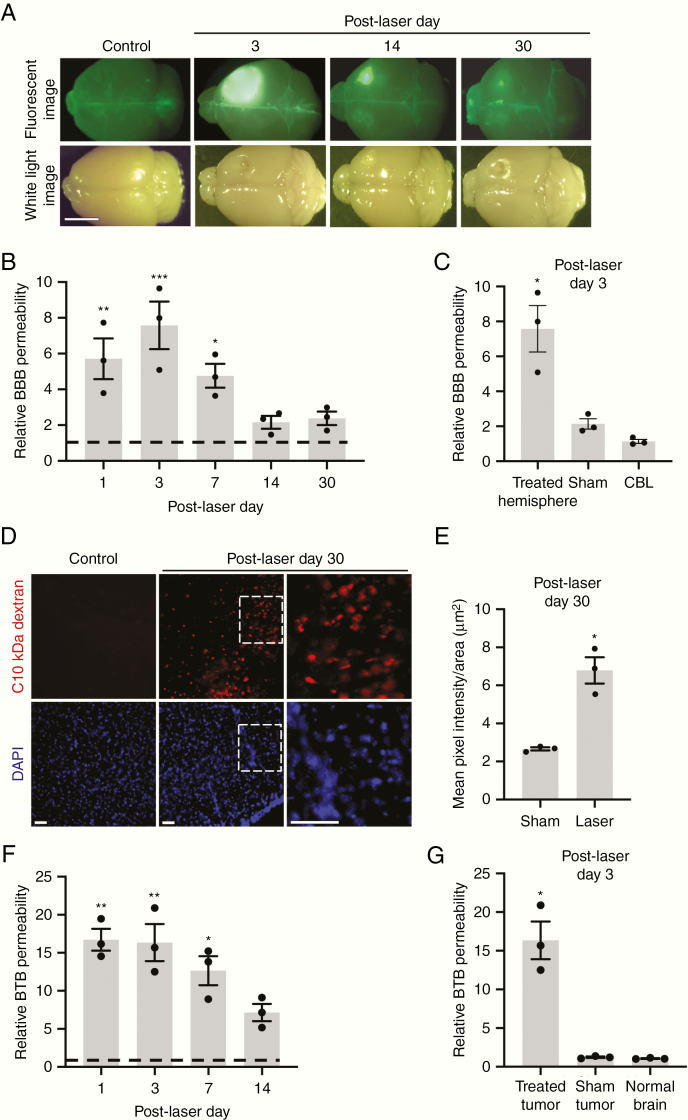
LITT increases BBB and BTB permeability in vivo. (A) Representative white light and fluorescence images of mouse brains harvested on the indicated days after intravenous fluorescein injection (n = 3 for each condition). LITT was performed in the right somatosensory cortex. Control = unmanipulated brain. Scale bar = 5 mm. (B) Animals treated as in A were assessed for tissue fluorescein uptake (normalized to control brains) on indicated post-LITT days. Control = 1 (dotted line). Data represent mean ± SEM. Laser increased BBB permeability compared to control (n = 3 for each condition, ANOVA, *P < .05, **P < .01, ***P < .001). (C) Relative BBB permeability was measured as in B on post-laser day 3 in indicated brain regions. LITT increased BBB permeability in the treated forebrain hemisphere, but not in the cerebellum (CBL) of the same brain or sham treatment (insertion of optical fiber) (n = 3 for each condition, ANOVA, *P < .01). (D) Animals treated with laser were injected intravenously with 10 kDa dextran on post-LITT day 30, and brains processed for immunofluorescence on free-floating 50 µm sections to assess dextran penetration. Representative images are shown (n = 3 for each condition). Scale bar = 50 µm. (E) Brain permeability of 10 kDa dextran was quantified by the mean pixel intensity of fluorescence divided by area (µm2). Data represent mean ± SEM (n = 3 for each condition, unpaired t-test, *P < .01). (F) Animals were orthotopically implanted with GL261 tumor cells, and laser treatment to the tumor performed 7 days later. Relative BTB permeability (normalized to control brain) was assessed by quantification of tissue fluorescein uptake on indicated post-LITT days. Control = 1 (dotted line). LITT increased BTB permeability compared to control (n = 3 for each condition, ANOVA, *P < .01, **P < .001). (G) Relative BTB permeability was measured as in (F) on post-laser day 3 following LITT (treated) or sham treatment. The normal brain represents a contralateral forebrain hemisphere with no tumor and not treated with laser. Laser treatment increased BBB permeability in the tumor-bearing hemisphere compared to sham treatment and contralateral hemisphere (n = 3 for each condition, ANOVA, *P < .001).